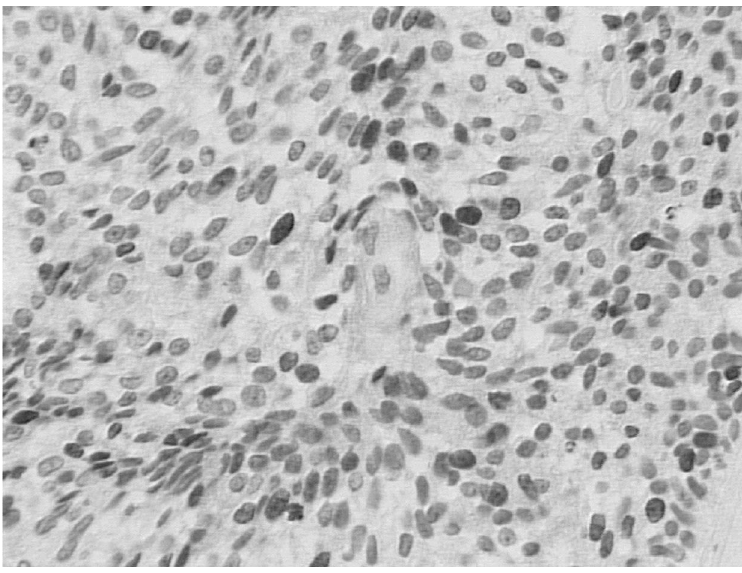
Fig. 2. IHC stained cells of a bladder